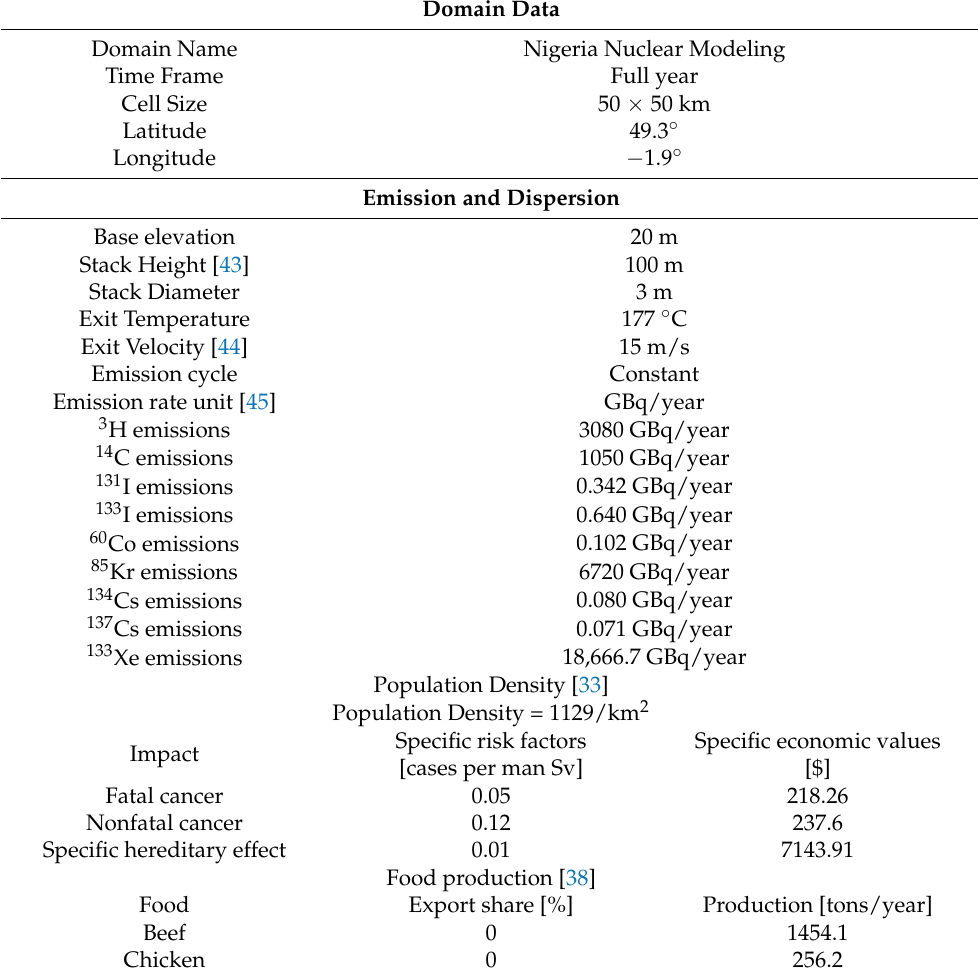
Table 5. Input data required to assess environmental impacts and associated health and damage costs of radionuclide emissions from a nuclear power plant using SIMPACT